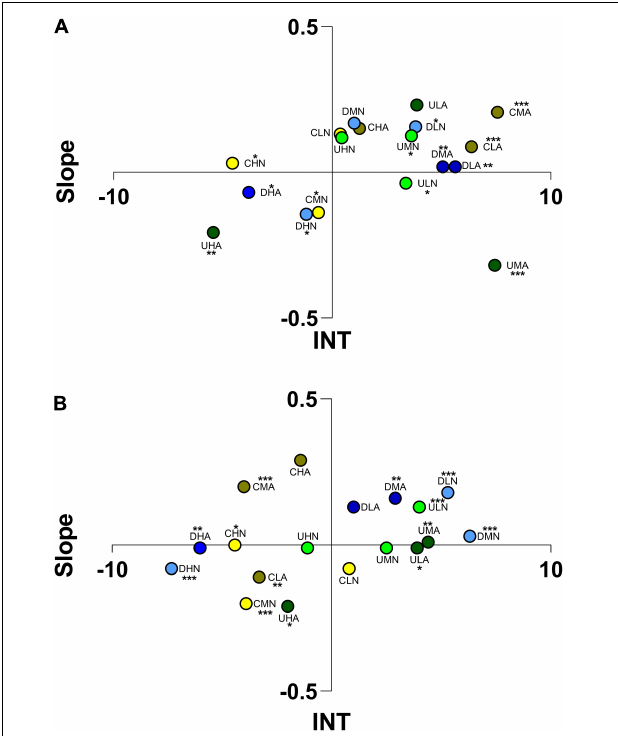
FIGURE 9 | Ordination into 1 of 4 sectors of Idotea balthica adults according to the scores reached for “Slope” and “INT” (integral time) in static arenas (A) and flow-through flumes (B) . The letters indicate the algae considered (C, Cocconeis scutellum var. parva ; D, Diploneis sp.; U, Ulva prolifera ), the concentration of VOCs (L, low; M, medium; H, high), and the culture and test conditions (N, normal conditions; A, acidified conditions). Asterisks indicate the significance of individuals’ position in the space.